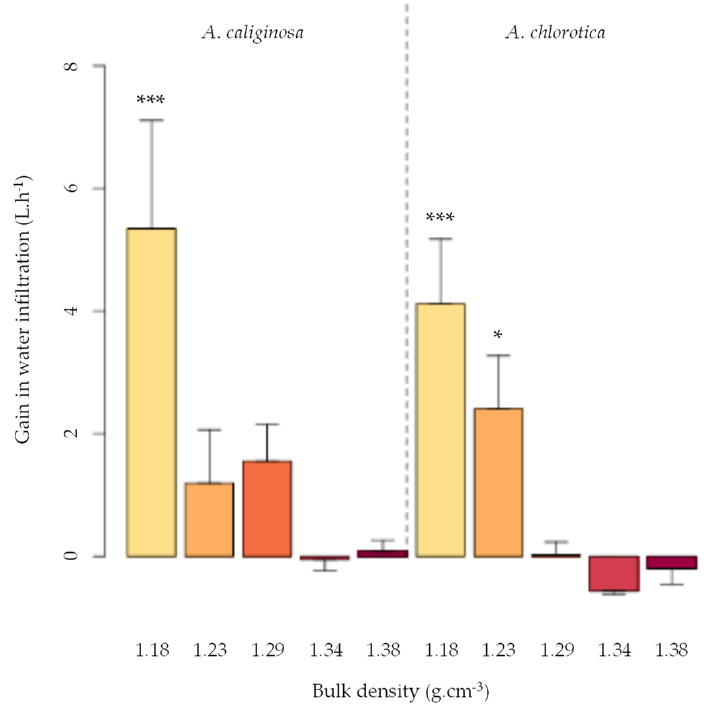
Figure 5. Gain in water infiltration (means + standard error) compared to control without earth- worms when three individuals of either Aporrectodea caliginosa or Allolobophora chlorotica endogeic lumbriculids were incubated for 6 weeks in soil cores with increasing bulk densities. Stars indicate values significantly different from zero (each species was tested separately) [89].